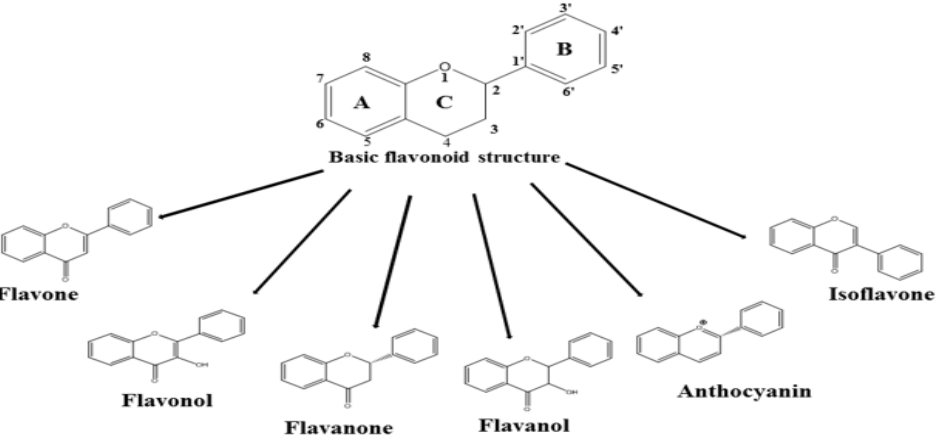
Figure 1. Structure of Flavonoids.